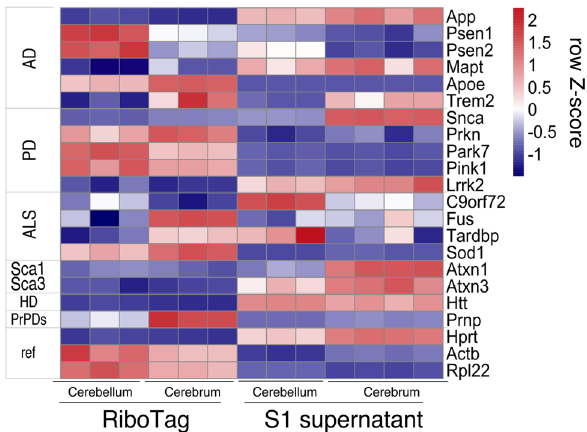
Figure 6. Expression of ND-related genes across the cerebellum and the rest of the brain in astroglia (RiboTag) and total input samples (S1